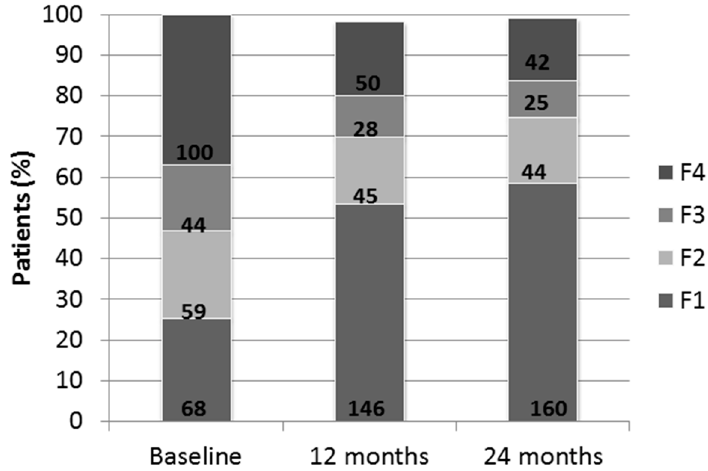
Figure 1. Distribution-elastography data by Fibroscan ® in 271 patients at baseline and 12 and 24 months. Distribution of patient percentage in order of elastography classification. Bold numbers indicate absolute values.